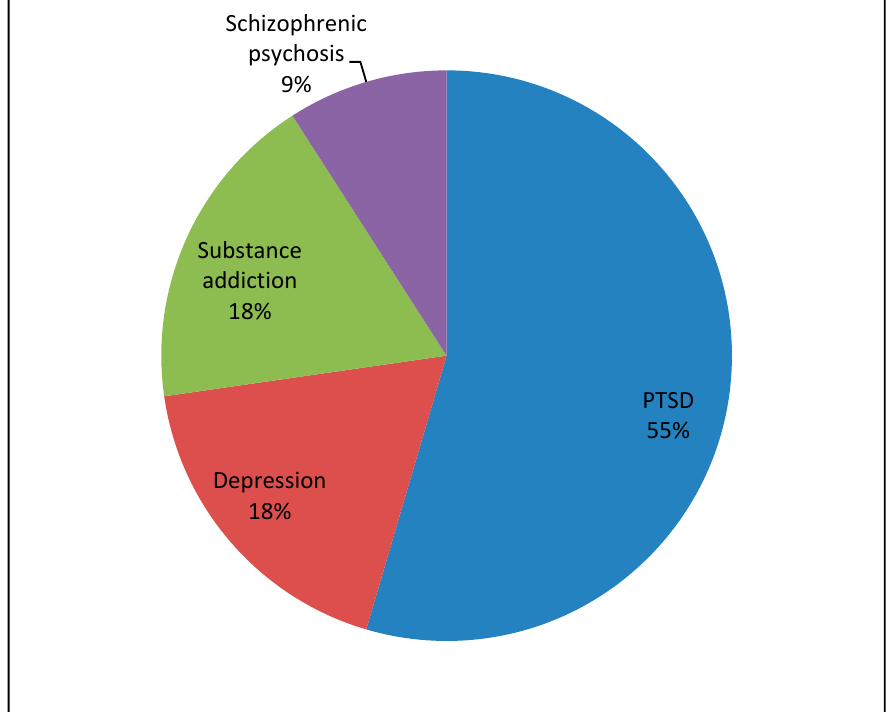
Figure 2. Results from the reflective diaries: showing the proportion of different diagnoses which were made in the outpatient clinic for psychosocial medicine.